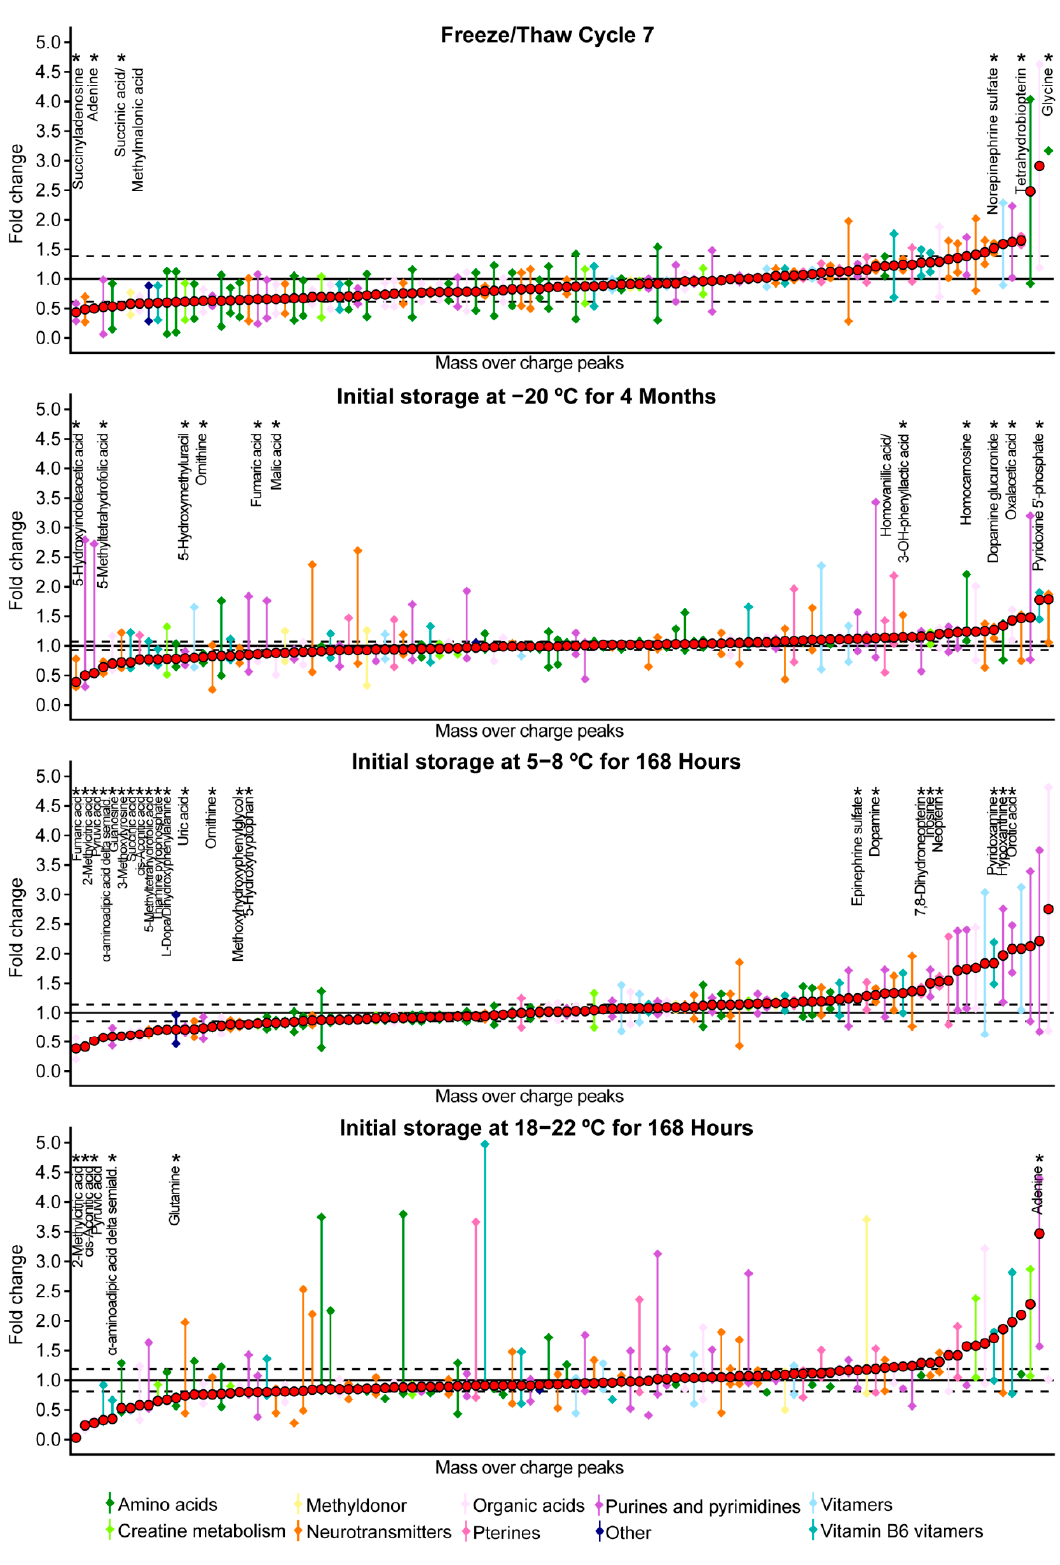
Figure 2. m / z peaks corresponding to metabolites important for neurometabolic diagnostics that are possibly affected by the most extreme storage conditions compared to the reference sample, after correction for the analysis variability. The y-axis depicts the fold change of the most extreme storage condition compared to the reference sample; the x-axis depicts the 106 m / z peaks corresponding to metabolites important for neurometabolic diagnostics (as listed in Table 2). Colored diamonds depict the upper and lower limit of the 95% confidence intervals; colored lines depict the range of the 95% confidence interval. Red filled circles depict the mean fold change. Colors depict the group of